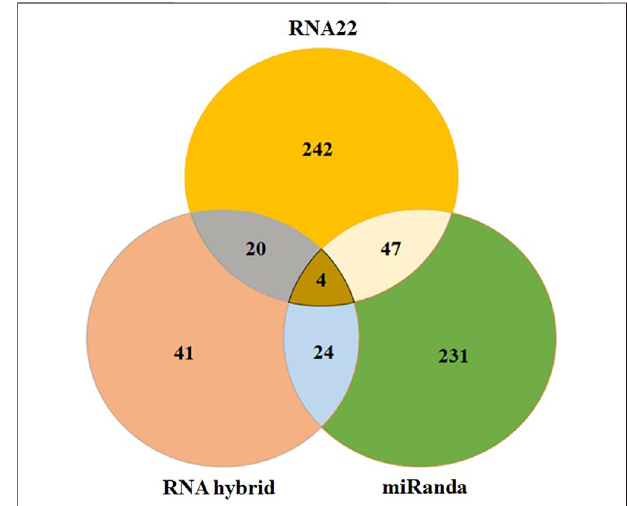
FIGURE 6 | The Venn diagram of miRNAs predicted to bind to in fl uenza C virus genomein by all three different tools: RNAhybrid, RNA22, and miRanda. The intersection graph showed four common miRNAs: hsa-mir- 3155a, hsa-mir-6796-5p, hsa-mir-3194-3p and hsa-mir-4673,